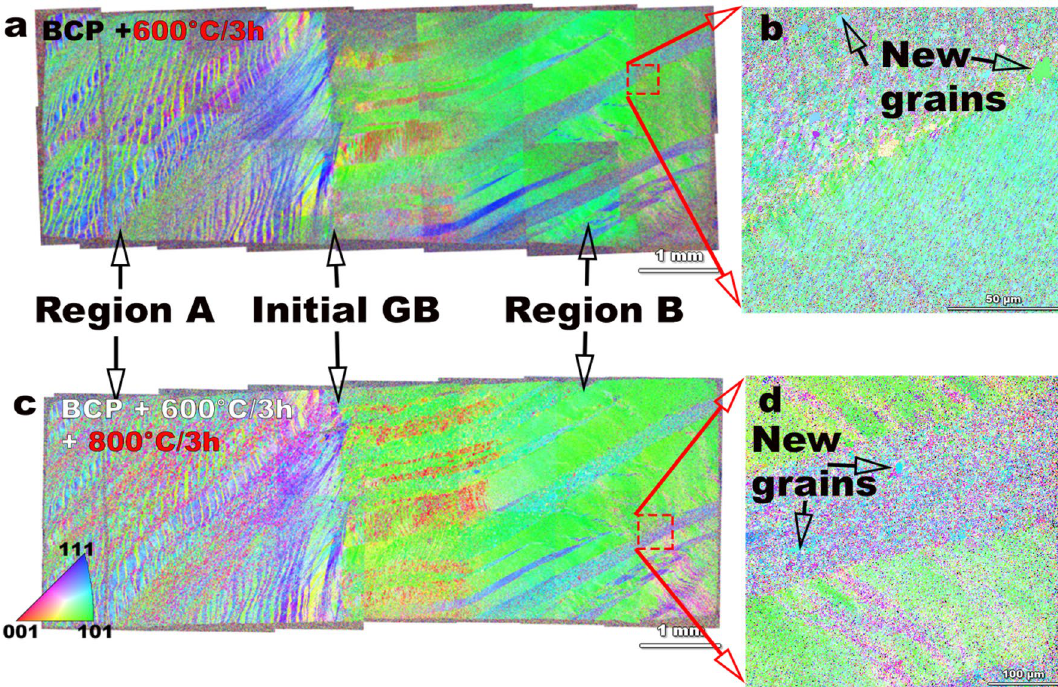
Figure 2. SEM-EBSD IPF maps of the entire bi-crystal after deformation and heat treatment at ( a ) 600 °C/3 h, and ( c ) after 800 °C/3 h. Extended high resolution IPF maps show some new grains that emerge from the deformed matrix after 600 °C/3 h ( b ), and 800 °C/3 h ( d ). There are no major texture variations or microstructure changes up to 800 °C/3 h heat treatment. Significant grain growth processes are not active even at 800 °C/3 h heat treatment condition in this study. The legend decribes the color codes for grain orientation. The IPF’s were generated using the TSL OIM Analysis (Version 7.0), link: https ://www.edax.com/produ cts/ebsd/ oim-analy